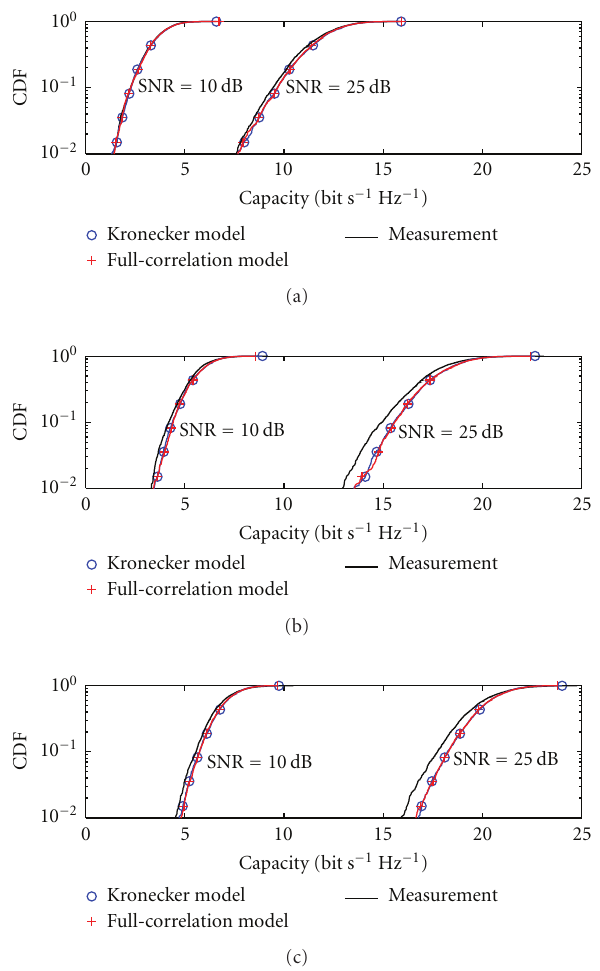
Figure 4: Comparison of the Kronecker model and full-correlation model against reverberation chamber measurement of 2 × 3 (a), 4 × 3 (b), and 6 × 3 (c) CDF of MIMO capacities, with SNR = 10dB and 25dB, all at 900